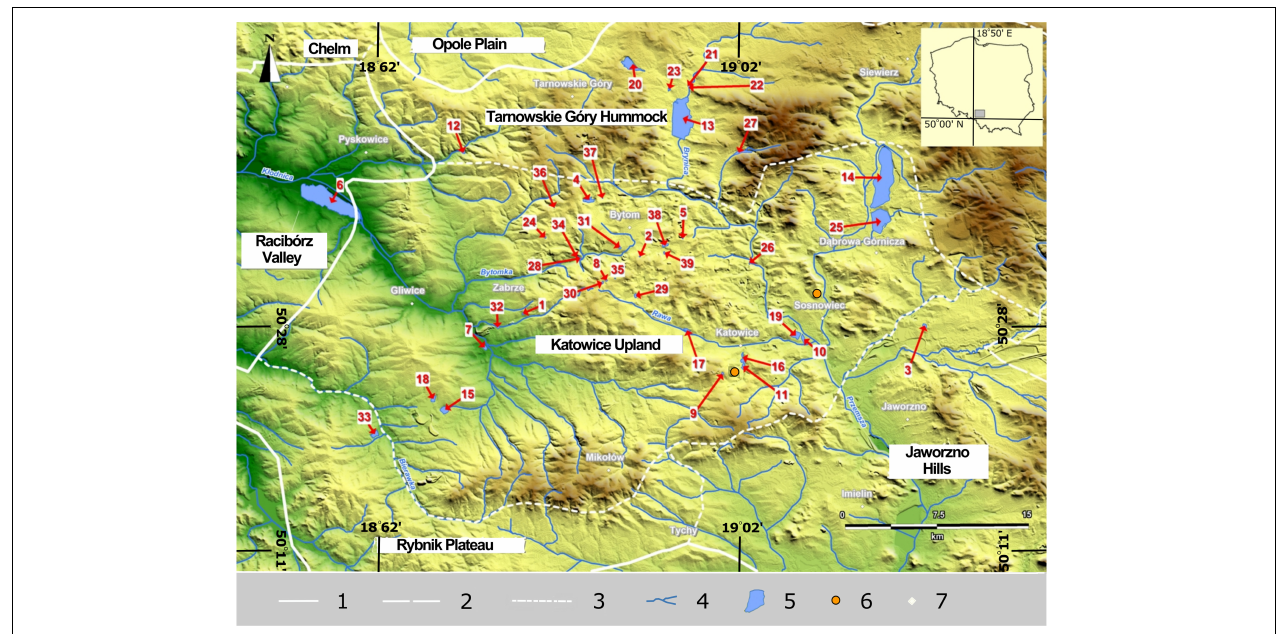
FIGURE 1 | Location of the anthropogenic water bodies studied in the Silesian Upland: 1–province boundaries, 2–macroregion boundaries, 3–mesoregion boundaries, 4–rivers, 5–water bodies studied (numbering as in Table 1 ), 6–meteorological stations, and 7–major